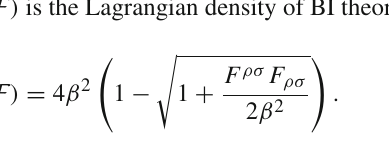
Fig. 1 Wheeler–DeWitt (WDW) patch of black holes. The left panel represents WDW patch of black holes with single horizon, the right panel represents WDW patch of black holes with double